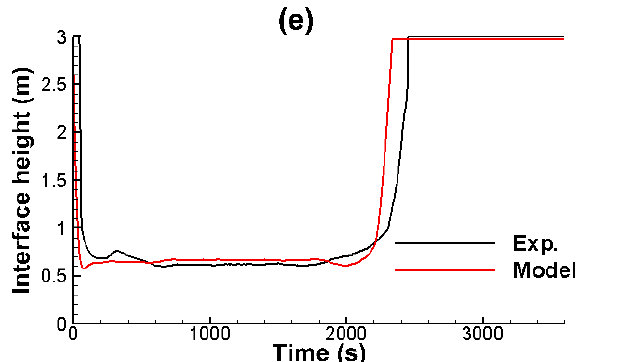
Figure 13. Test 5: ( a ) individual and total HRRs, ( b ) average gas temperature, ( c ) average wall temperatures, ( d ) volume fractions of O 2 and CO 2 in the exhausted gases, and ( e ) smoke layer interface height.